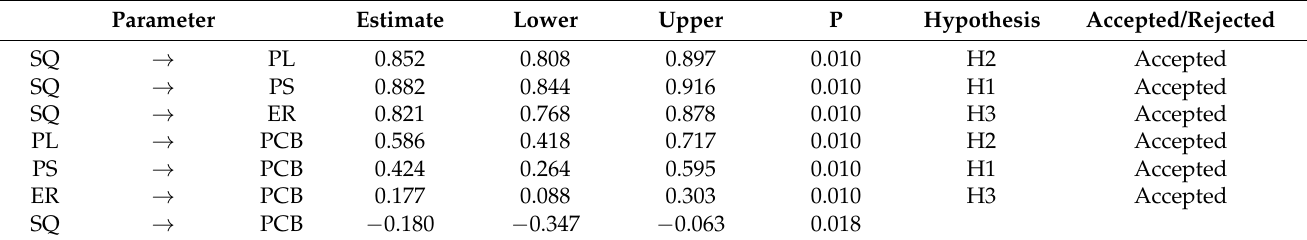
Table 3. Direct Effects Between